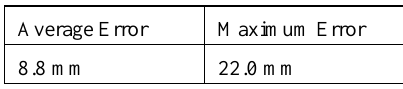
Table 2. Experimental